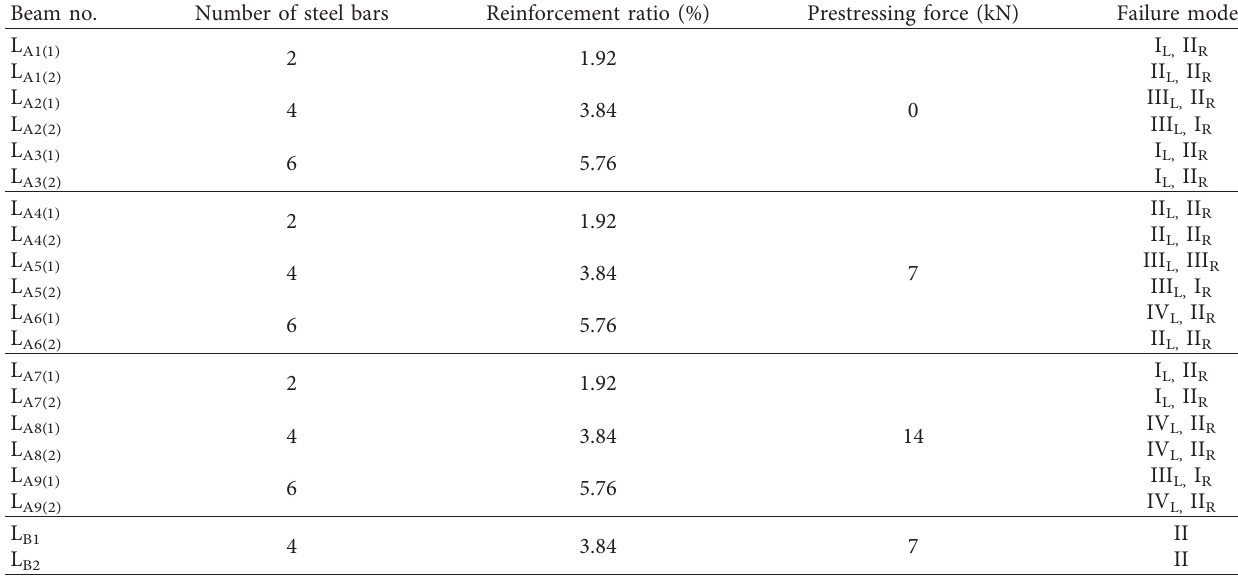
Table 4: Failure modes of simply supported beams and continuous beams. Beam no.